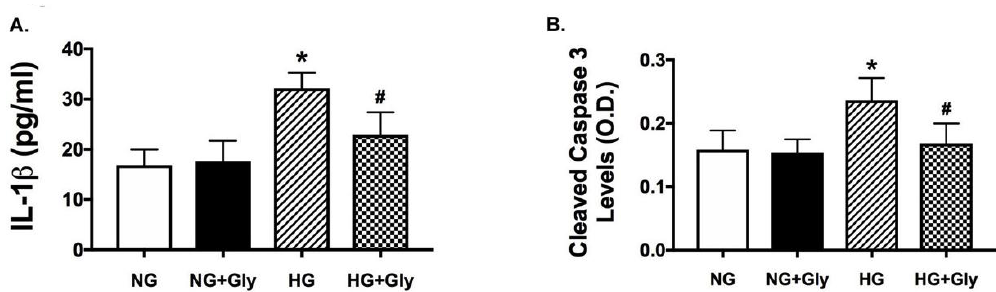
Figure 6. IL1 β and cleaved caspase 3 are reduced by glycyrrhizin in retinal endothelial cells (REC) grown in high glucose. REC were grown in normal (5 mM) or high (25 mM) glucose alone or treated with 2mM glycyrrhizin. ( A) shows IL1 β and ( B) shows cleaved caspase 3. * p < 0.05 vs. NG, # p < 0.05 vs. HG. n = 5 for each group.